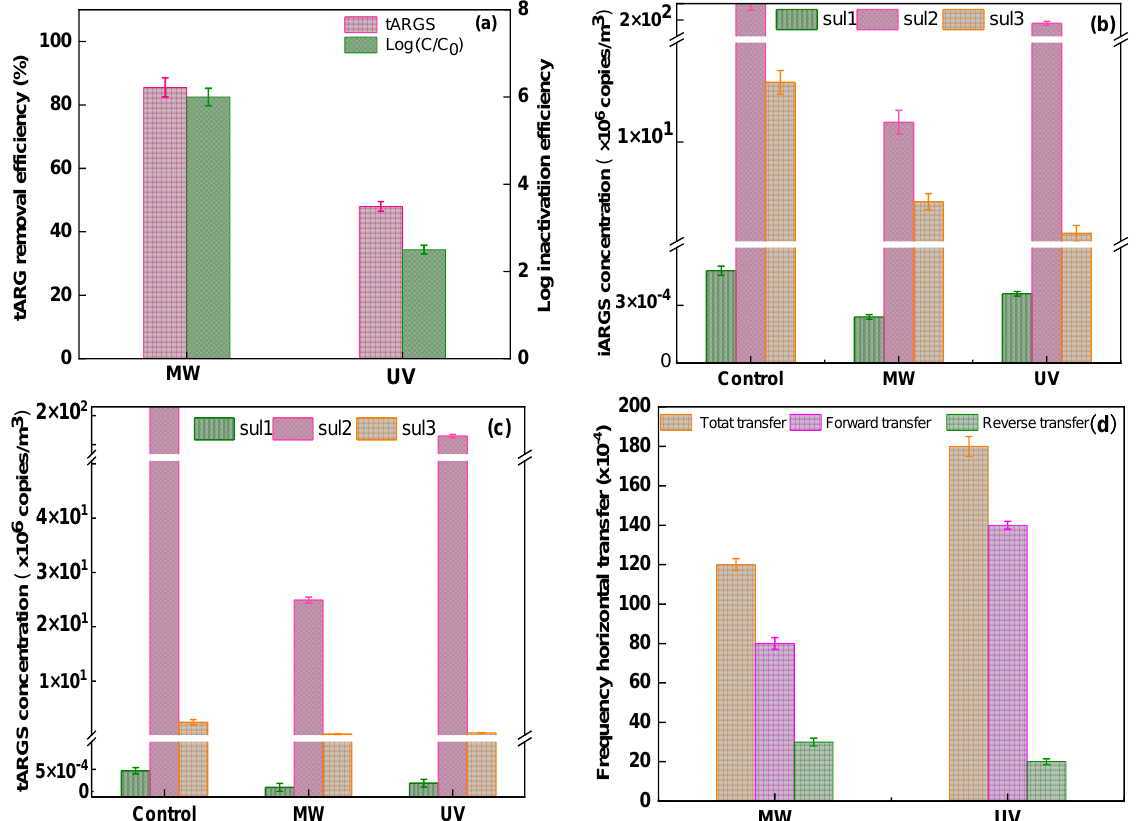
Figure 5. Comparison of MW and UV on ( a ) the removal of E. coli 10667 ( sul ) and tARGs, ( b ) individual iARGs concentrations, ( c ) tARG concentrations, and ( d ) effects of MW and UV irradiation on HGT frequency.